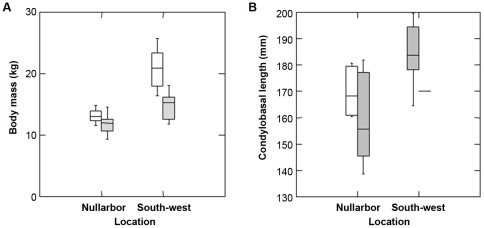
Boxplots for (A) the estimated body mass (kg) and (B) condylobasal length (mm) of dingoes and thylacines from Holocene cave deposits from the south-west and Nullarbor regions of Western Australia.Open bars denote dingoes and grey bars denote thylacines. The box indicates one quartile either side of the median, and the bars indicate two quartiles on either side of the median. The median is indicated by the bar within the box.